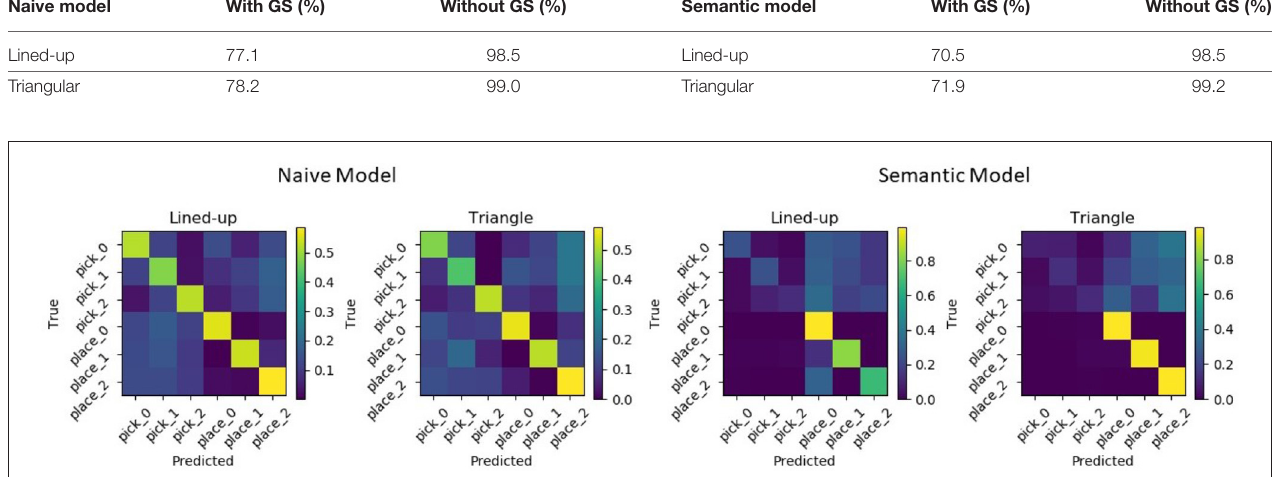
FIGURE 17 | Normalized confusion matrices for the naive (left) and semantic (right) models for both configurations when training and testing the model without the grasping state feature. The semantic model achieves a slightly higher overall accuracy but fundamentally recognizes highly accurately just the placing